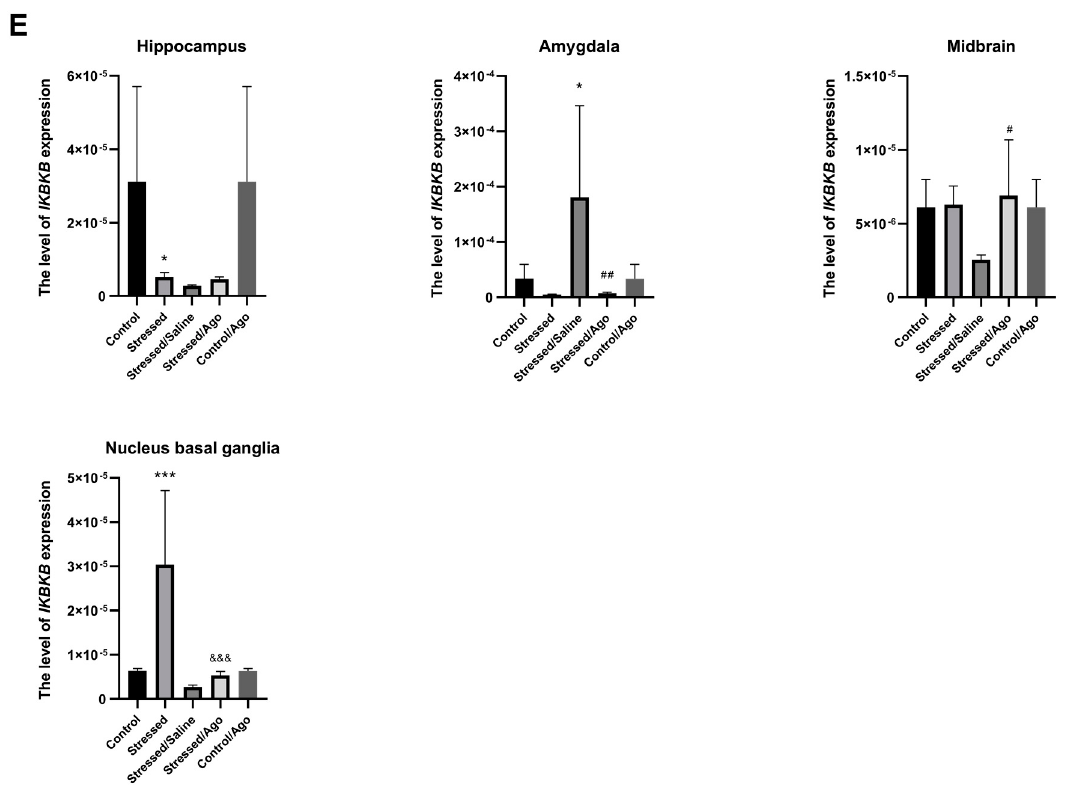
Figure 2. mRNA expression of TGFA ( A ), IKBKB ( B ), TGFB ( C ), IRF1 ( D ) and PTGS2 ( E ) in the brain structures of animals exposed to chronic mild stress (CMS) for two weeks (Control, Stressed) and in animals exposed to CMS for seven weeks and administered vehicle (1 mL/kg) or venlafaxine (10 mg/kg) for five weeks (Control/Venla, Stressed/Saline, Stressed/Venla). Relative gene expression levels were estimated using a 2 − ∆ Ct (Ctgene–Ct18S) method. Data represent means ± SD. N = 6. * p < 0.05; ** p < 0.01; *** p < 0.001 relative to Control group. # p < 0.05; ## p < 0.01; ### p < 0.001 relative to Stressed/Saline group. & p < 0.05; && p < 0.01; &&& p < 0.001 relative to Stressed group. TGFA (A) Amygdala Stressed/Saline vs. Control ANOVA p = 0.004, Tukey’s test p = 0.046; Stressed/Ago vs. Stressed/Saline ANOVA p = 0.004, Tukey’s test p = 0.007; Midbrain Stressed/Saline vs. Control ANOVA p < 0.001, Tukey’s test p < 0.001; Prefrontal cortex Stressed/Ago vs. Stressed/Saline ANOVA p < 0.001, Tukey’s test p < 0.001; Nucleus basal ganglia Stressed vs. Control ANOVA p < 0.001, Tukey’s test p < 0.001, Stressed/Ago vs. Stressed ANOVA p < 0.001, Tukey’s test p < 0.001. Amygdala Stressed/saline